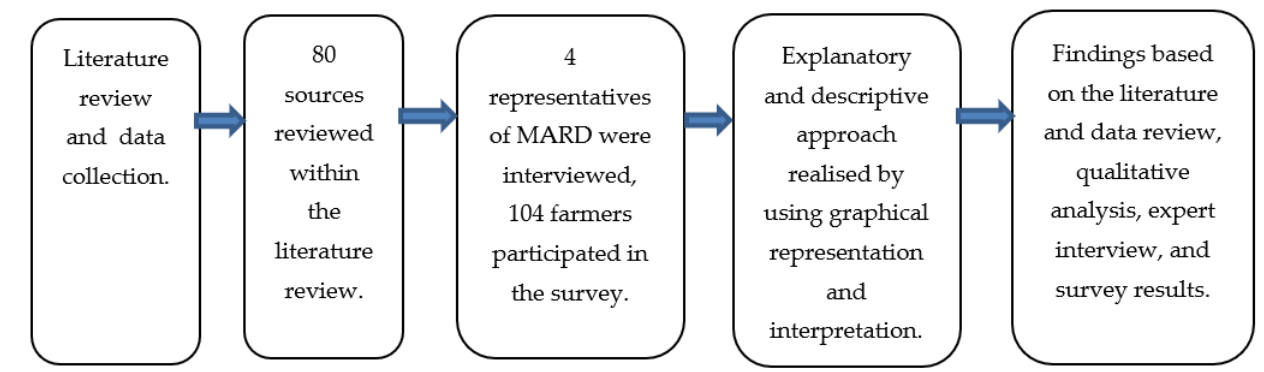
Figure 3. Material and methods used in the article. Source: own representation, 2021.